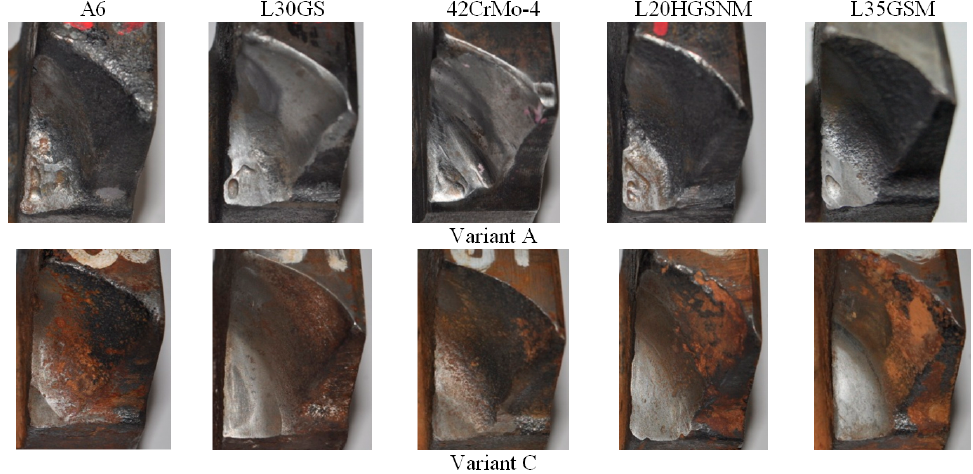
Figure 8. A view of chain wheel sockets after abrasive wear tests.